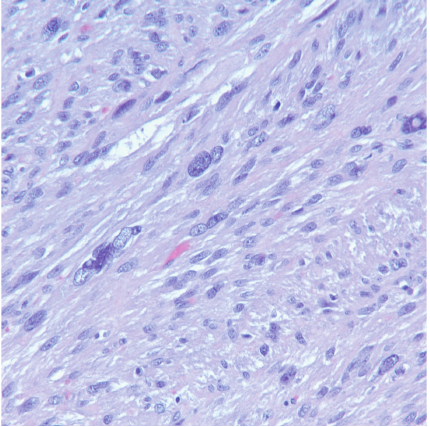
Figure 2: Hematoxylin and eosin stain of periurethral STUMP tissue showing di ff use moderate